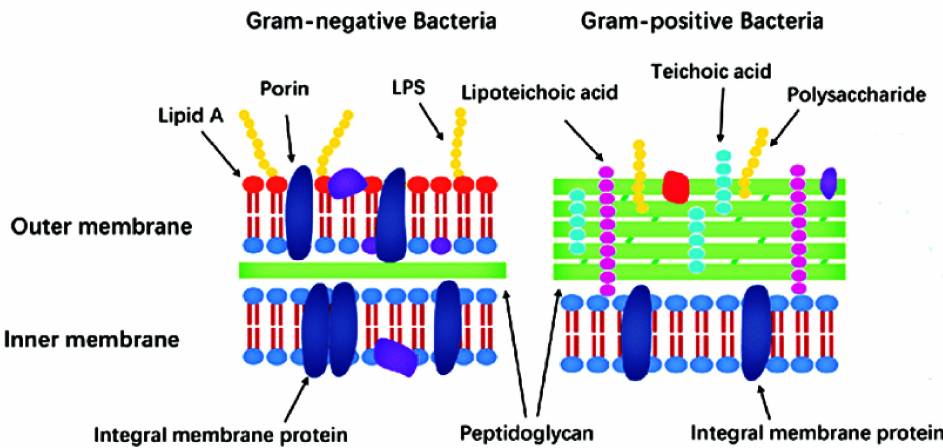
Figure 1. Comparison between Gram-negative and Gram-positive bacteria cell walls. Adapted from [22] with permission. Copyright © 2020 Huan, Kong, Mou and